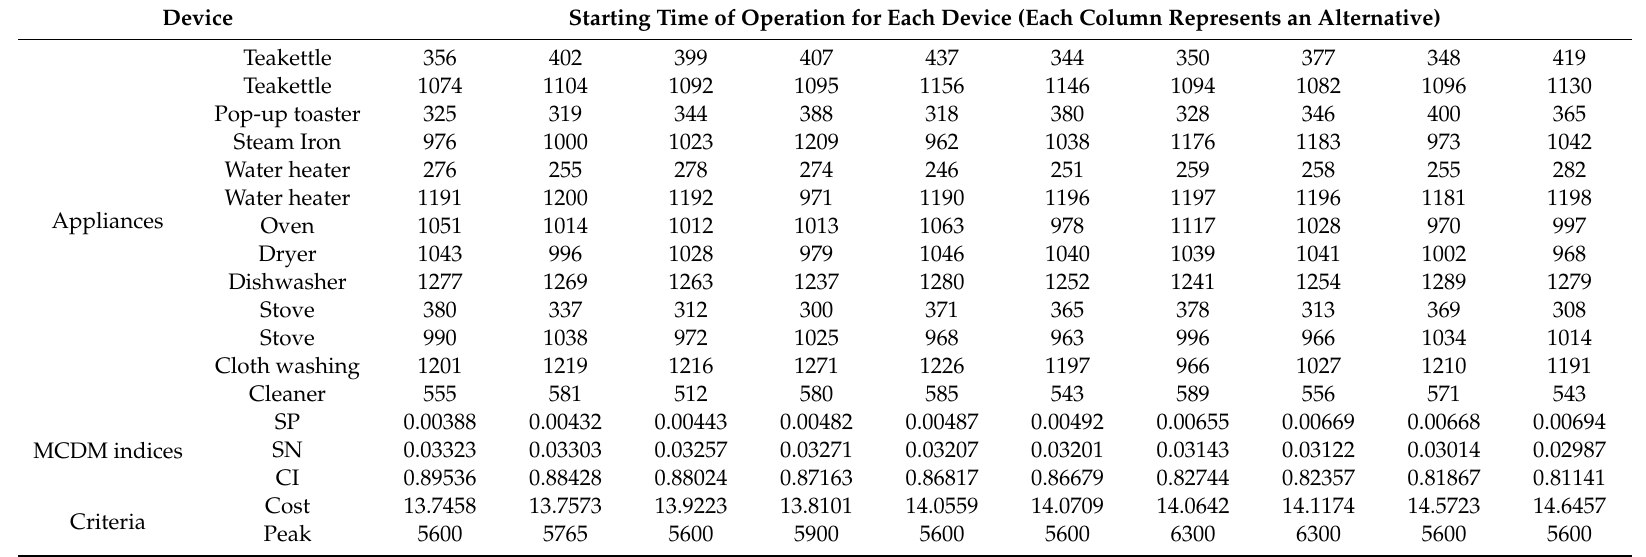
Table 8. Scores based on integrated AHP-TOPSIS for second